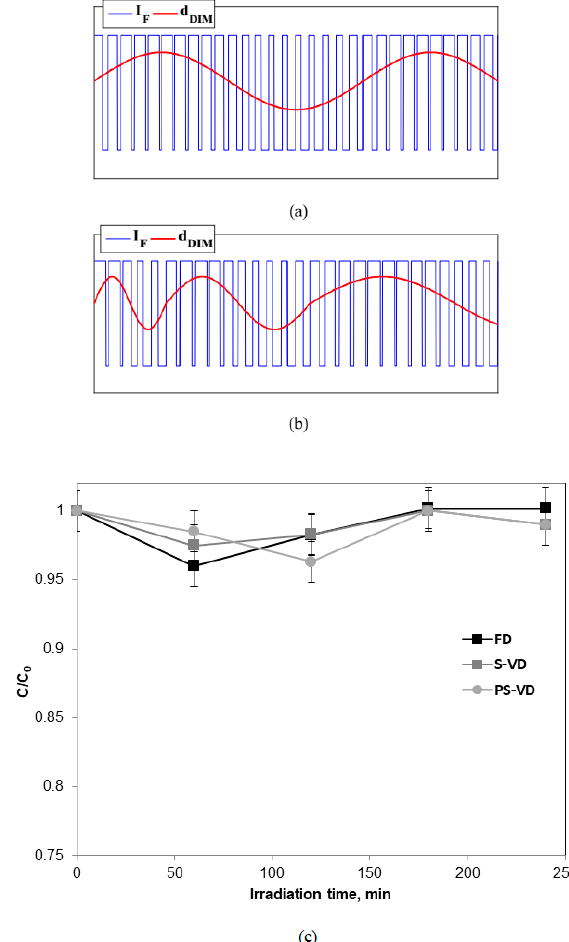
Figure 2. ( a ) Sinusoidal-variable duty (S-VD) LED dimming modulation; ( b ) pseudosinusoidal-variable duty (PS-VD) LEDs dimming modulation; ( c ) Photolysis of urea under visible light irradiation radiation using fixed duty (FD) LED dimming (48 W, 200 mA), S-VD LED dimming modulation, and PS-VD LED dimming modulation (25–78 W, 100–300 mA). Urea initial concentration: 250 mg / L; solution volume: 250 mL.